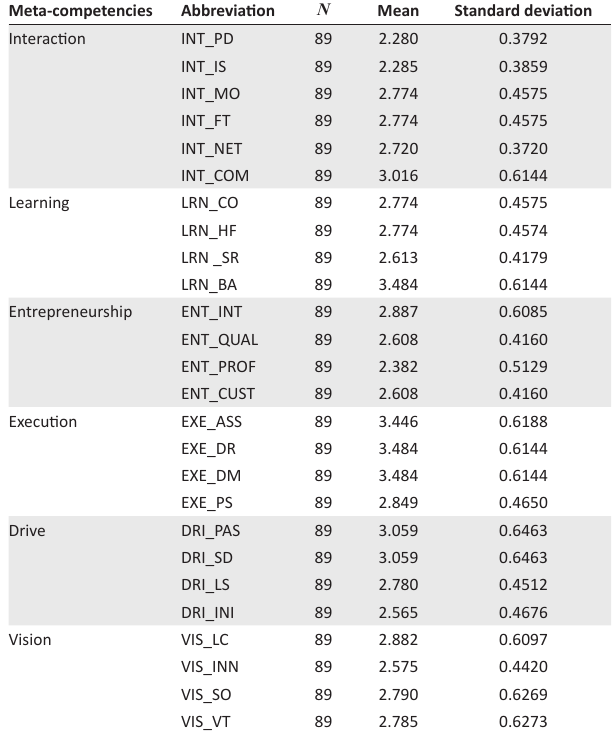
TABLE 2: Descriptive